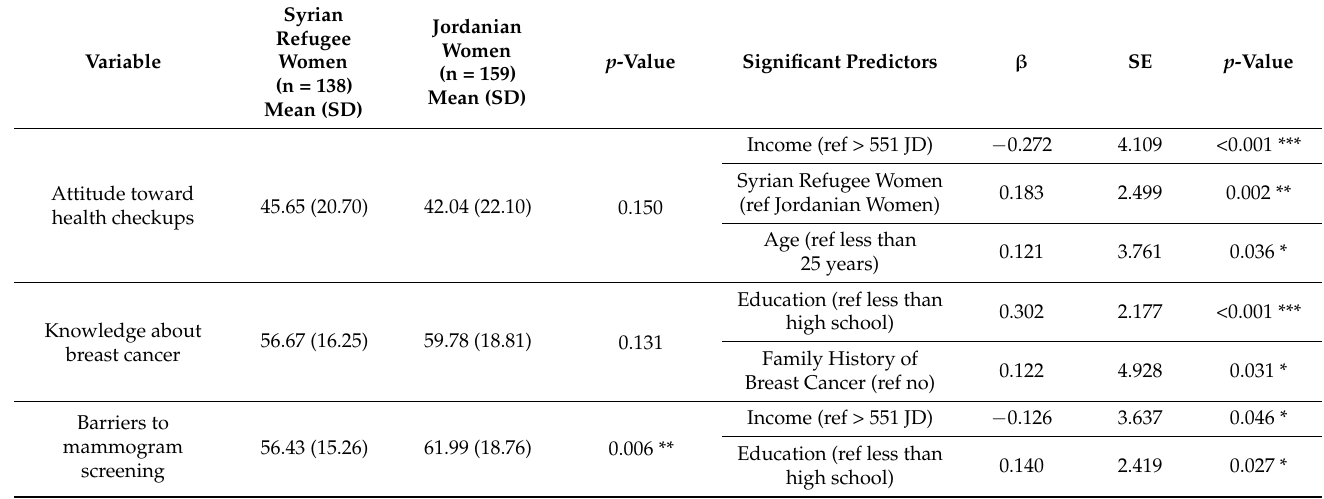
Table 4. BCSBQ subscales and linear regression for significant predictors of subscales